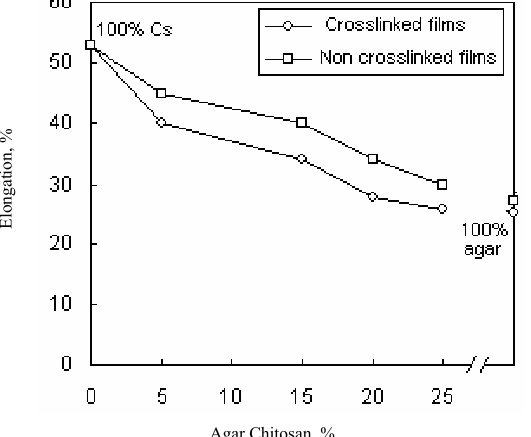
Figure 10. Variation of elongation% of non-crosslinked CS/Agar blended films and their crosslinked CS/Agar counterparts with the agar